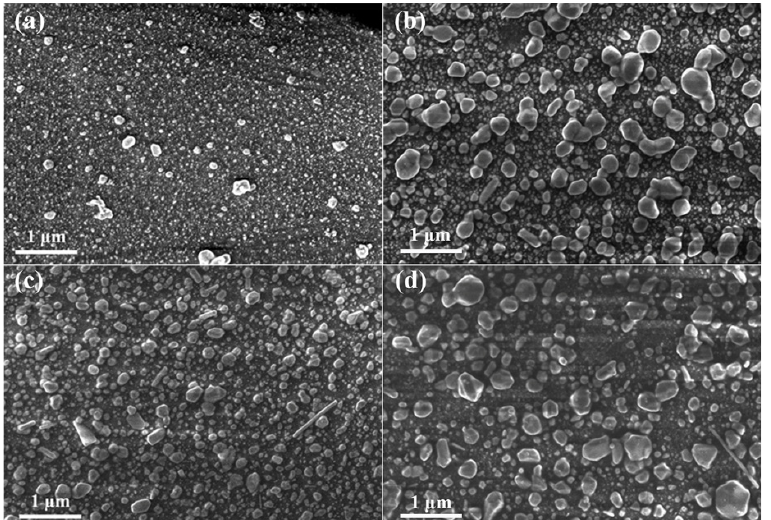
Figure 2. UV–Vis transmittance spectra of the chip showing the plasmonic dip evolution from 0 min. (black curve, water filled chip) to the final reaction time, with a 1 minute step (the same colour sequence is used in all graphs, starting from the red curve, corresponding to the silver precursor injection) for different synthesis conditions: ( a ) static synthesis using a 10 mM AgNO 3 solution at 20 °C; ( b ) static synthesis using a 100 mM AgNO 3 solution at 20 °C; ( c ) dynamic synthesis using a 10 mM AgNO 3 solution at 20 °C with a flow rate of 1 mL/min; ( d ) dynamic synthesis using a 100 mM AgNO 3 solution at 20 °C with a flow rate of 1 mL/min